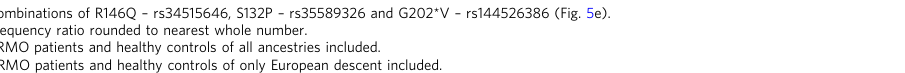
Table 3 Human MLKL brace helix compound heterozygotes in CRMO vs healthy controls. Population Frequency of relevant compound Hets a in CRMO Global c